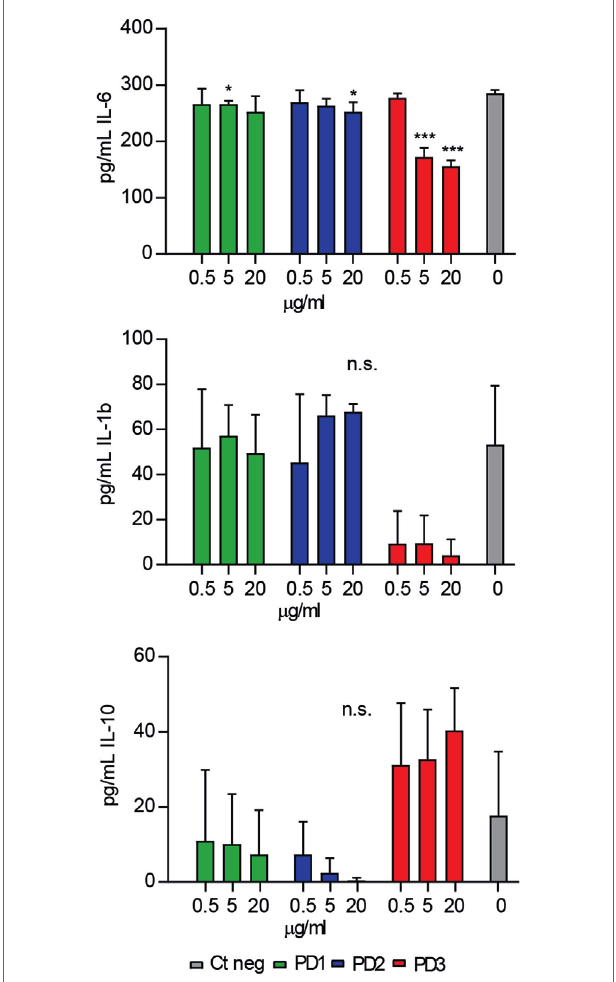
FigUre 4 | Effect of CD6-derived peptides on bacterial lipopolysaccharide (LPS)-induced cytokine release in vitro by mouse splenocytes. Total spleen cell suspension (2 × 10 5 ) from C57BL/6 mice ( n = 7) was stimulated in triplicate for 48 h with LPS (0.5 µg/mL), in the presence or absence of increasing concentrations (0.5, 5, and 20 µg/mL) of CD6-derived peptides (PD1, PD2, and PD3). Cytokine levels in culture supernatants were determined by ELISA and results expressed in pg/mL as mean ± SD of triplicates. Viability was > 75% at 48 h in all experimental conditions. Statistical analysis was performed using a two-tailed Mann–Whitney test, with confidence intervals of 95% (n.s., not significant; * P < 0.05; ** P < 0.01; and *** P <